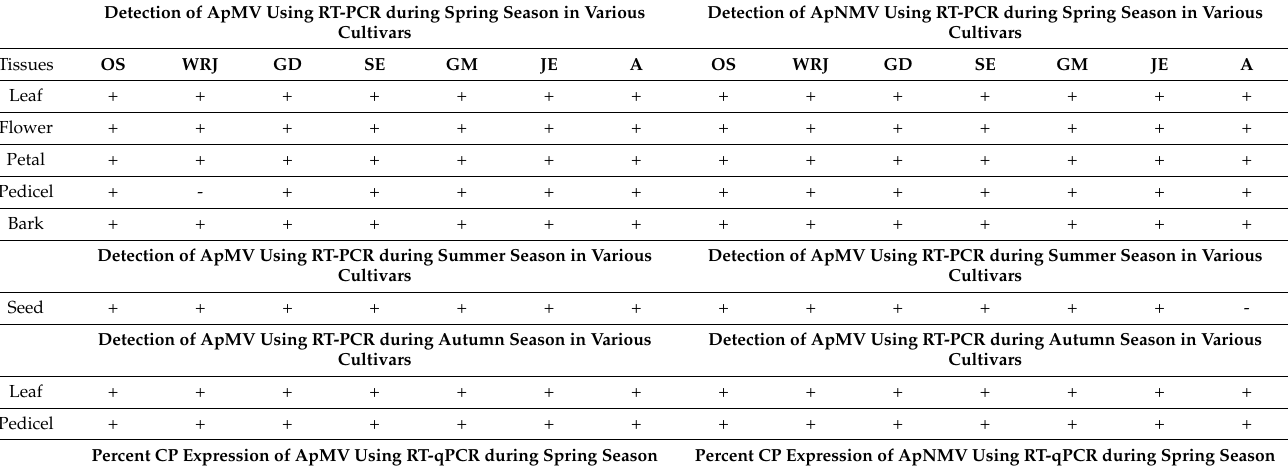
Table 3. Detection and percent expression of ApMV and ApNMV in different standardized tissues in different seasons in various mosaic-infected cultivars of